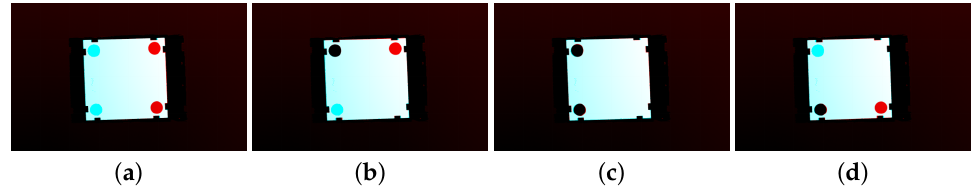
Figure 5. An example of an object with symmetric shape and asymmetric aspects. ( a – d ) Aligning by the outer shape, there are four possible alignments, but only one ( c ) is correct. (The template object is cyan, and the aligned one is red. Thus pure cyan represents a missing area and pure red an extra area.)